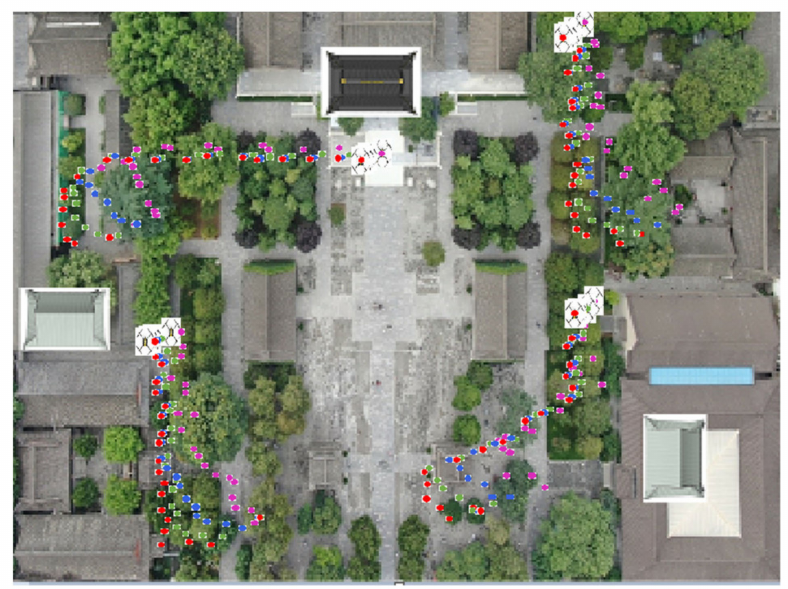
Figure 6. LS, UKF, ANN, UCP-IG method positioning trajectory (comprehensive scenario).